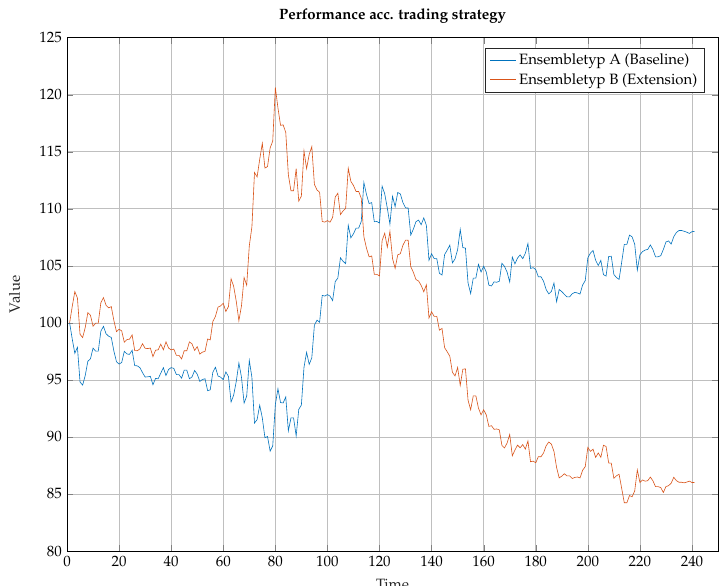
Figure 7. The VICs Prediction Information in a Trading